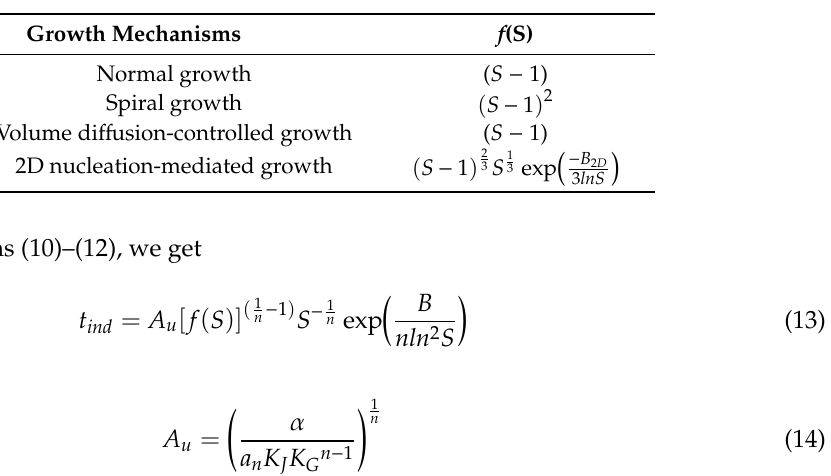
Table 1. The expressions of f ( S ) for di ff erent growth